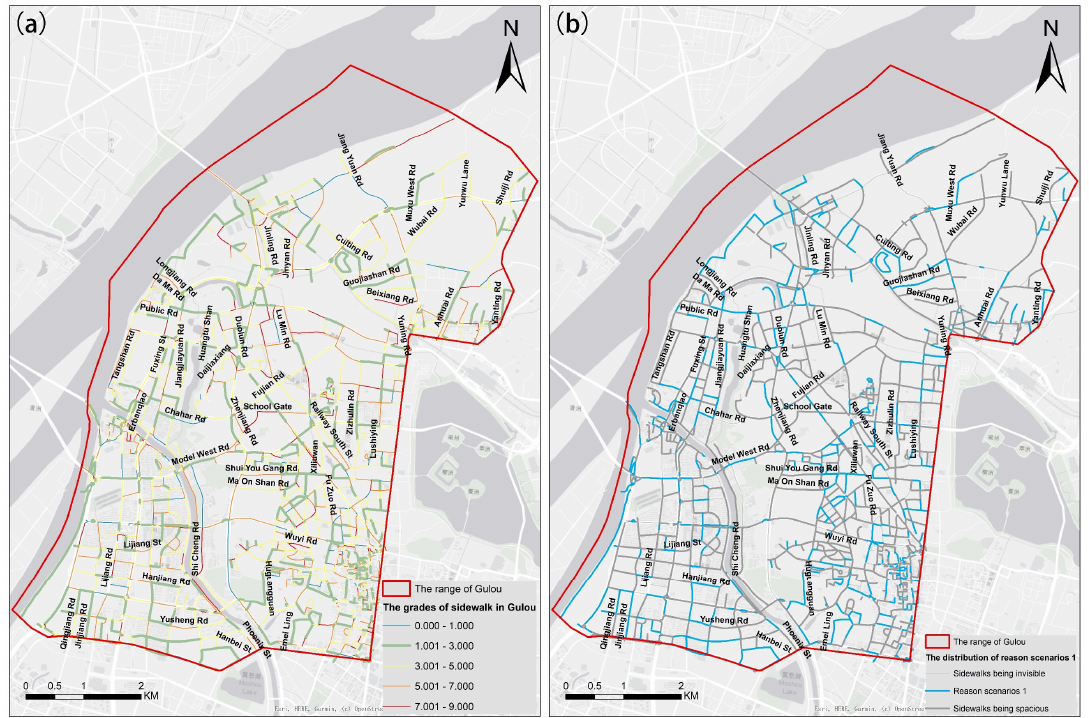
Figure 12. The distribution of sidewalks grades in Gulou ( a ) and the distribution of reason scenarios 1 ( b ).